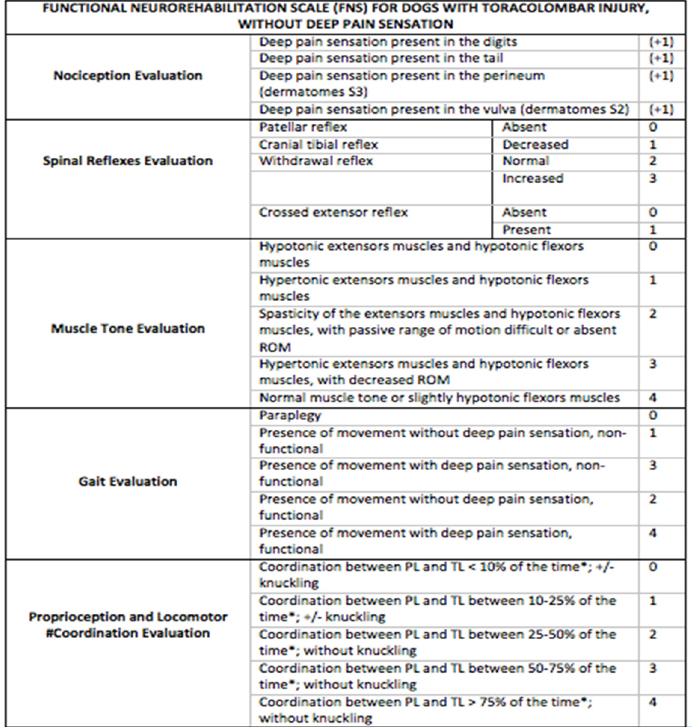
Figure 1. Functional neurorehabilitation scale for dogs with thoracolumbar spinal cord injury without deep pain perception. 31st Annual Symposium of the ESVN-ECVN [44]. Concerning the CG, 62 dogs were paraplegic DPP + with an absent/decreased flexor peripheral reflex and classified with OFS 1, and 43 dogs were paraplegic DPP −